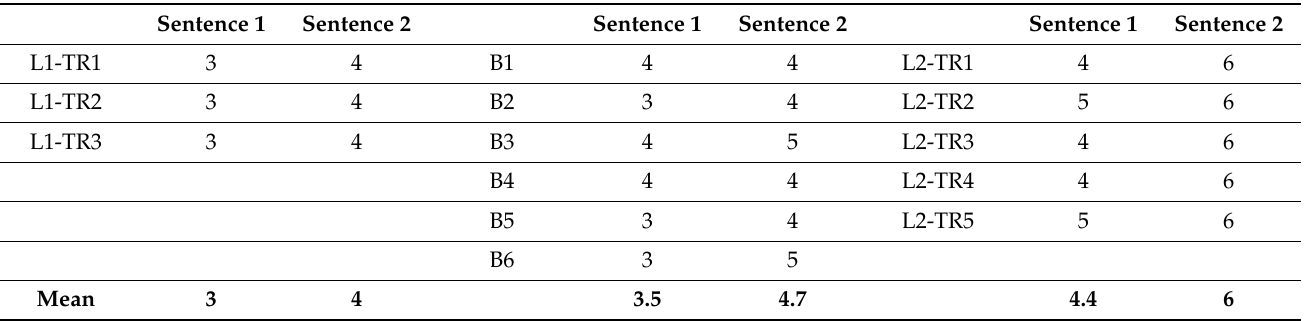
Table 8. Number of APs realized in the two target sentences. From left to right: L1 speakers